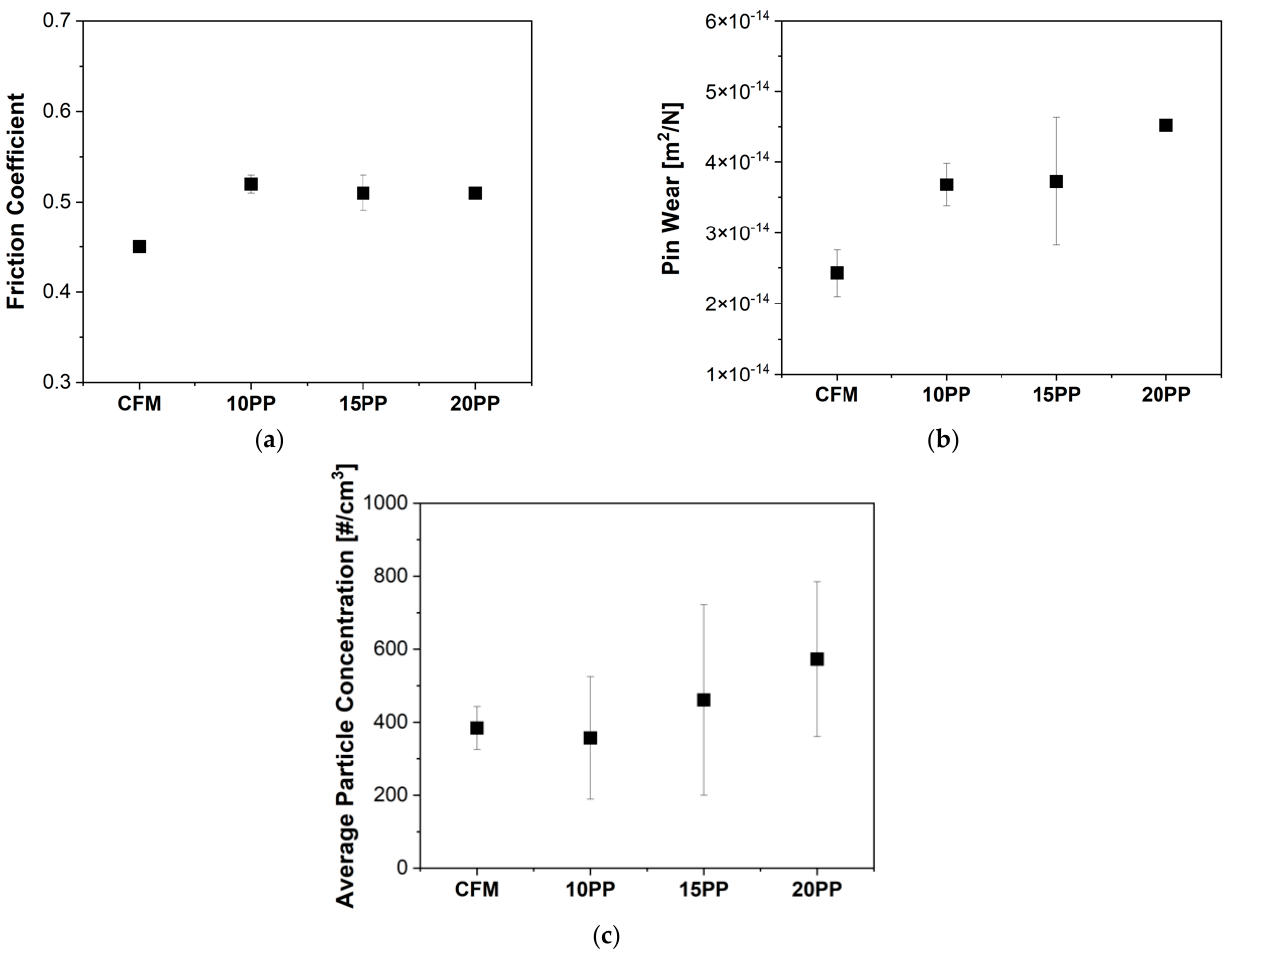
Figure 7. Comparison of ( a ) steady state CoF trends; ( b ) specific wear coefficient of pin; and ( c ) emission characteristics.